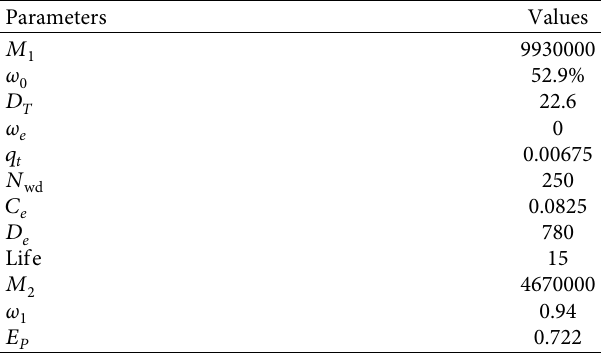
Table 2: Parameters of the economic beneft model.